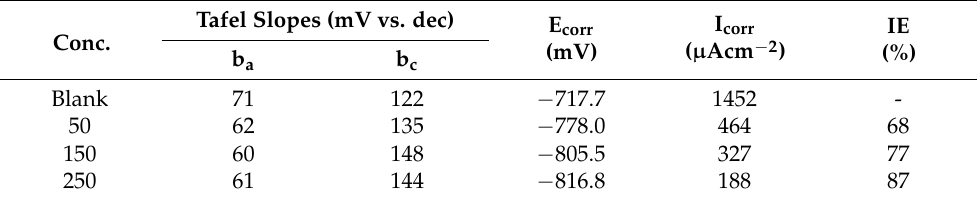
Table 4. Potentiodynamic polarization for T. aralioides at selected concentrations in 1M HCl at 303 ± 1 K. Tafel Slopes (mV vs. Conc.